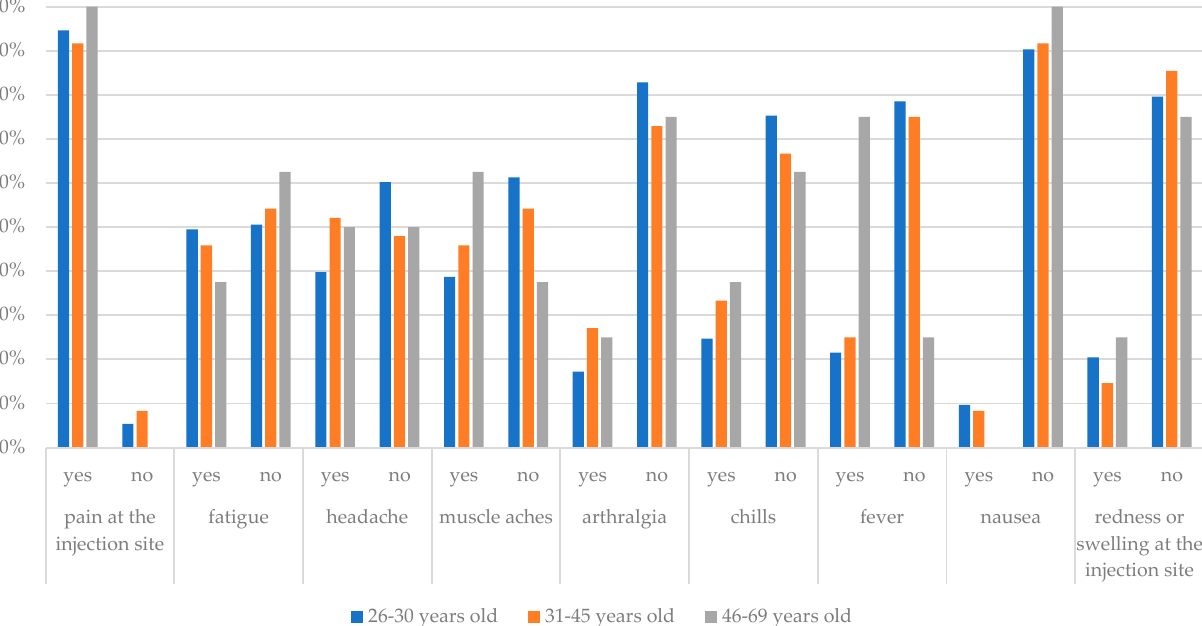
Figure 4. Comparison of the number of side effects after taking the vaccine with gender.